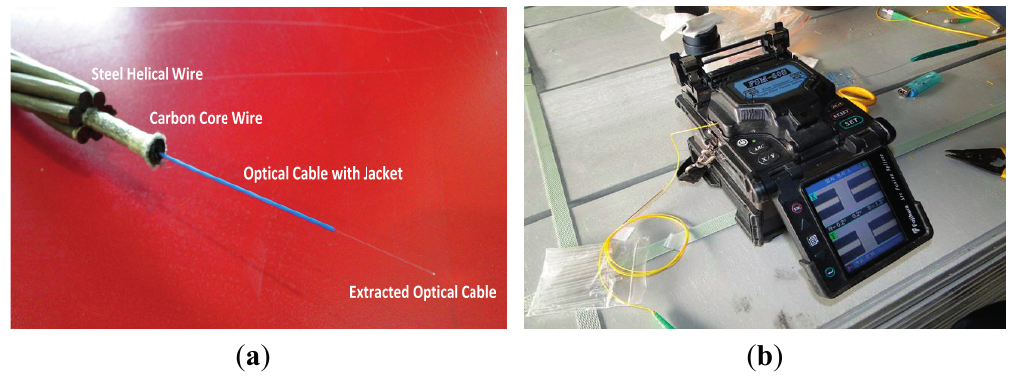
Figure 3. ( a ) Completed sensing strand and ( b ) optic fusion.